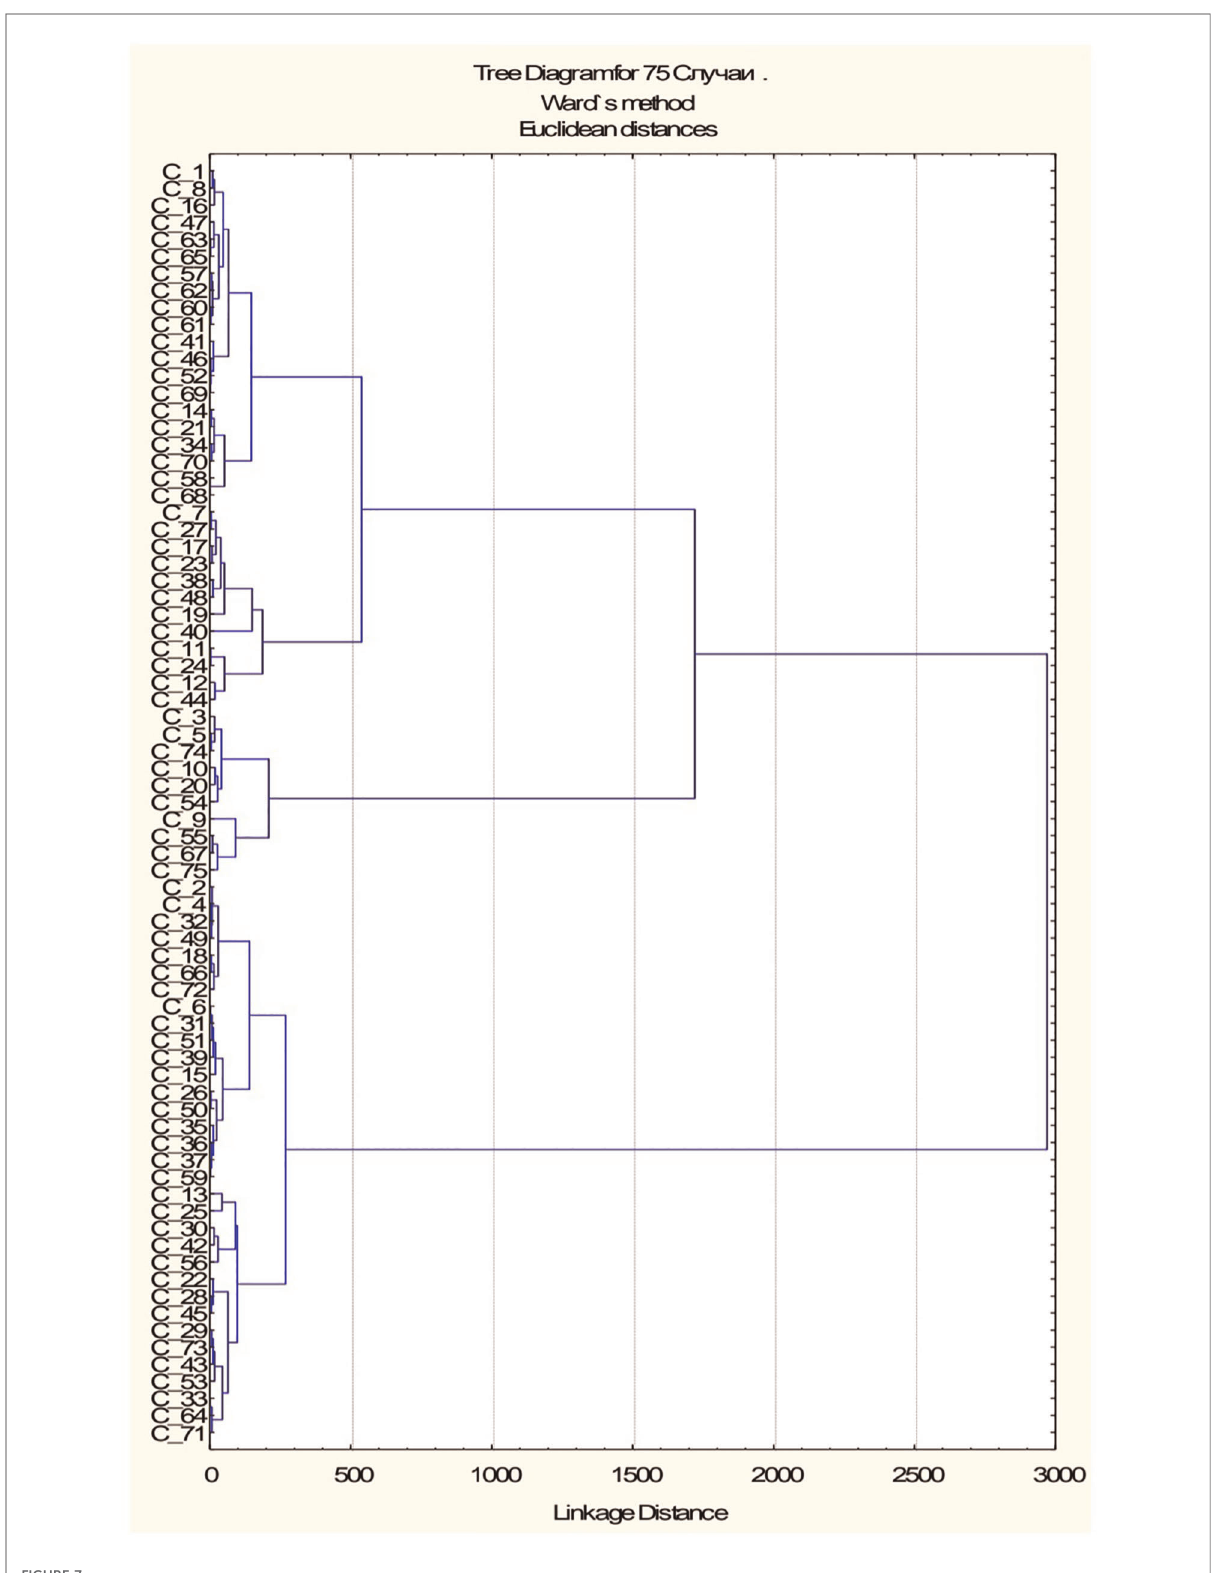
FIGURE 7 Ward ’ s hierarchical